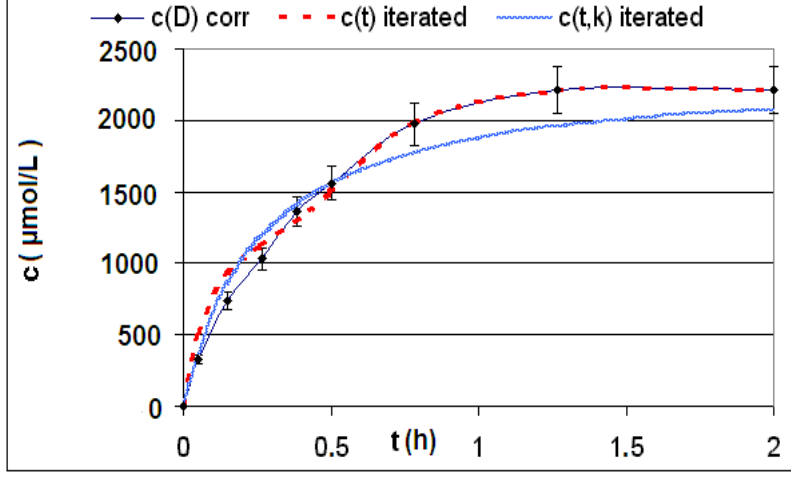
Figure 6. Reaction R6 comparison c